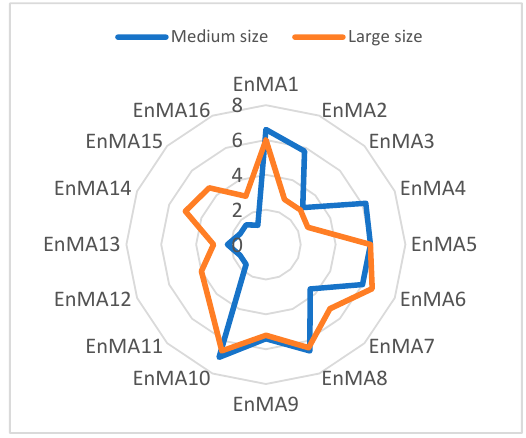
Figure 2. Comparing the results extracted from Table 2.